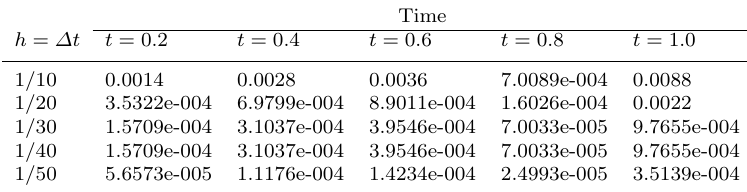
Table 2. The errors of (cid:107) u n − U n